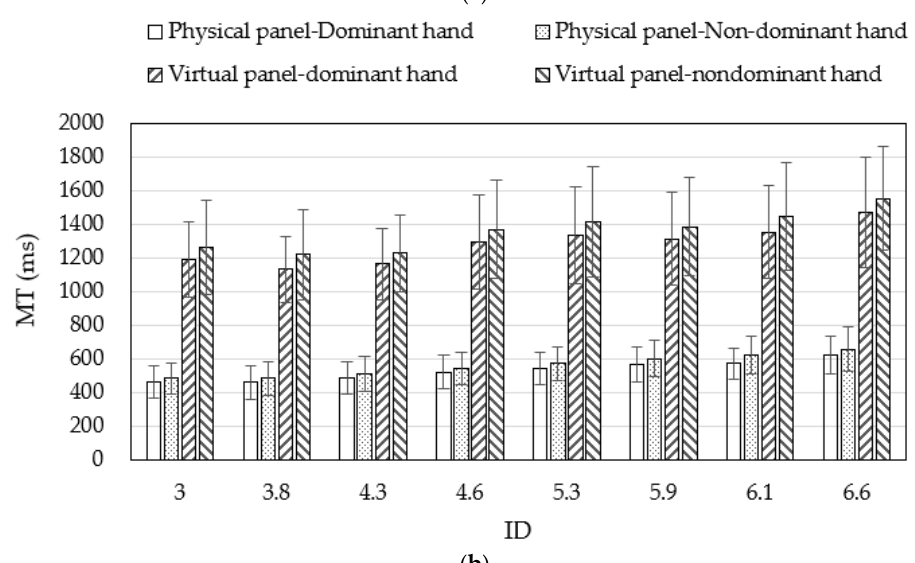
Figure 6. MT of female ( a ) and male ( b ) participants performing the vertical pointing task.